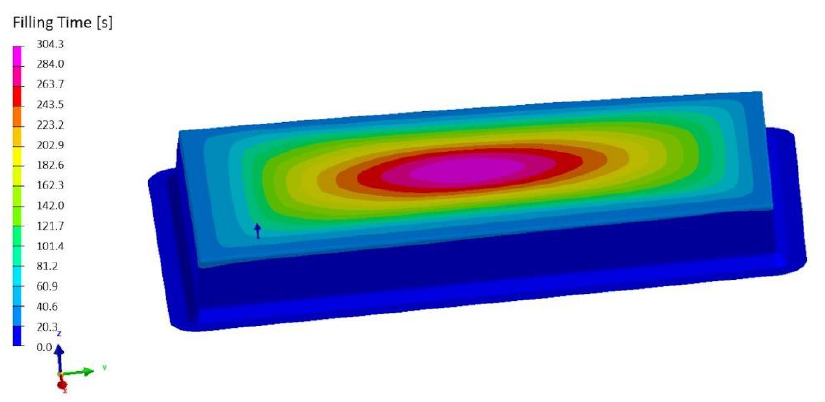
Figure 6. Contour plot of the filling time computed by the numerical model.